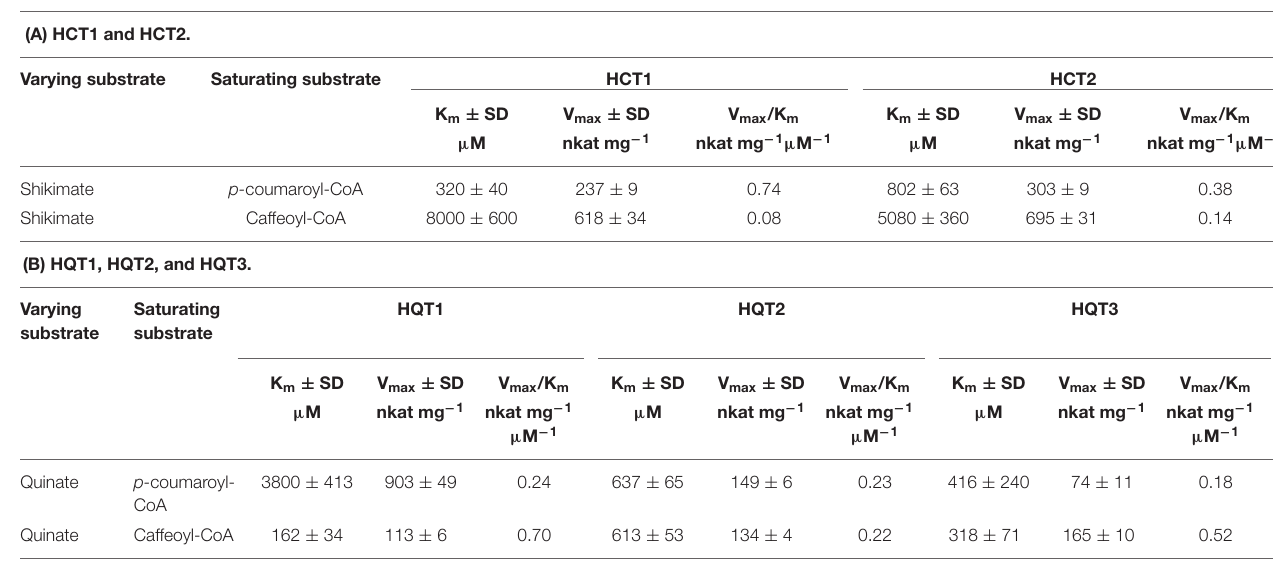
TABLE 1 | Kinetic parameters of HCTs and HQTs from